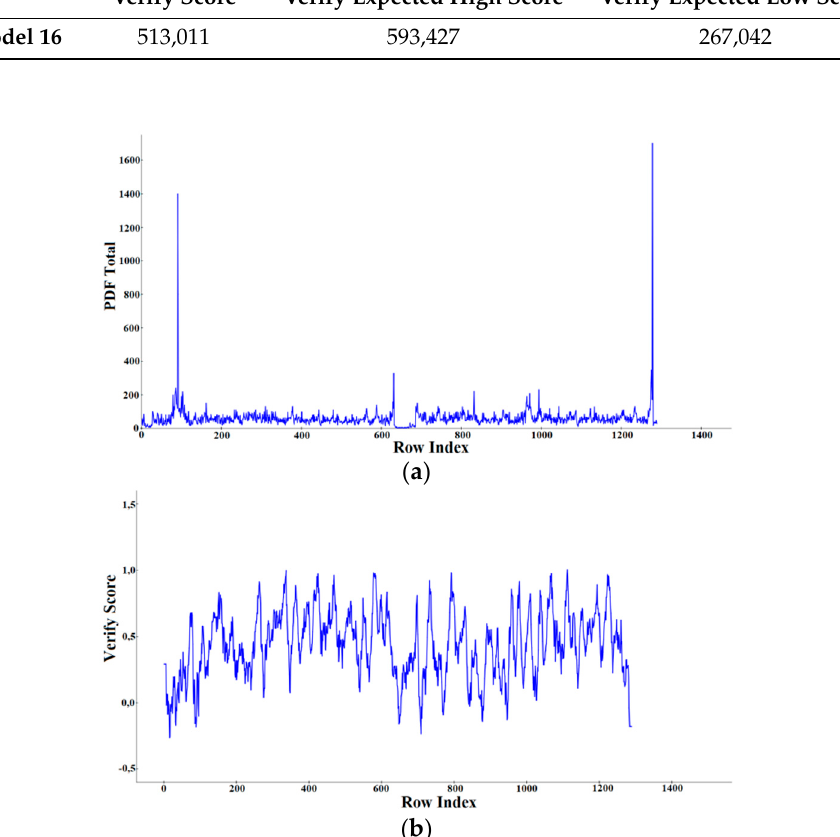
Figure 4. ( a ) PDF Total Energy Plot; ( b ) Verify Score Plot of the Model 16 generated by Discovery Studio 4.1 Client/Modeler 9.12 tool.